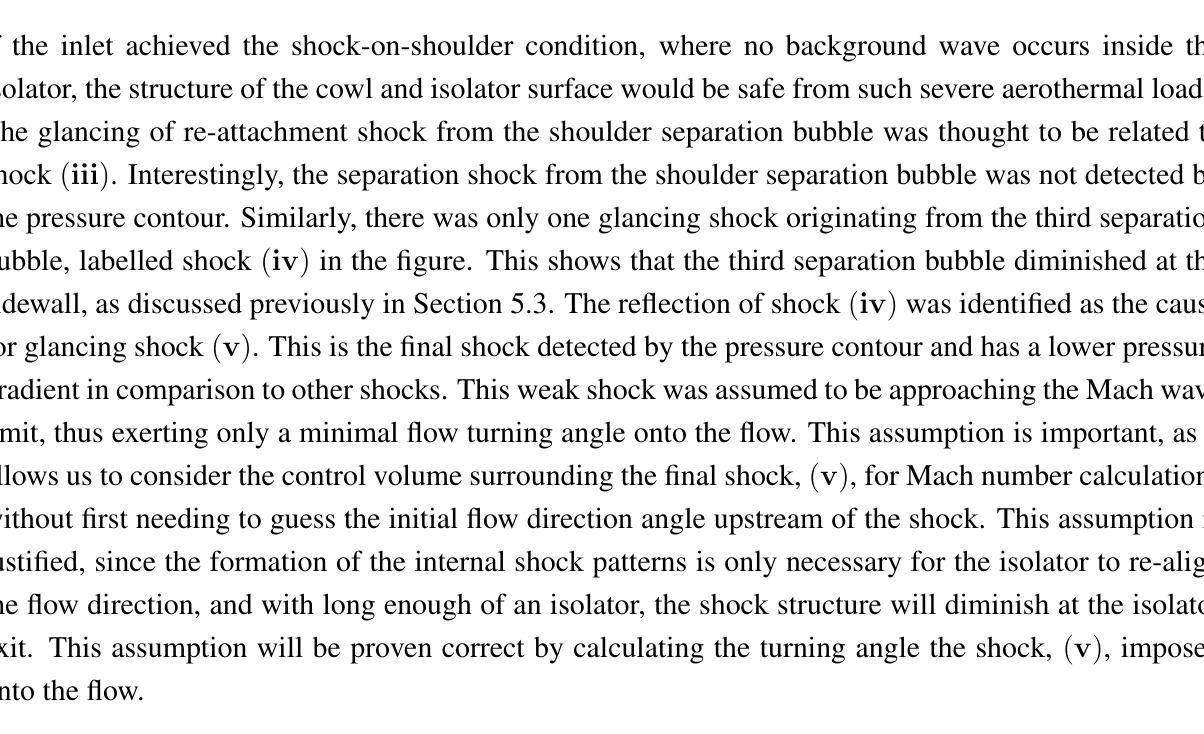
Figure 18. Normalized pressure contour on the isolator sidewall surface layered on top of the grey scale schlieren image for ( a ) baseline; ( b ) AoA-2; and ( c )